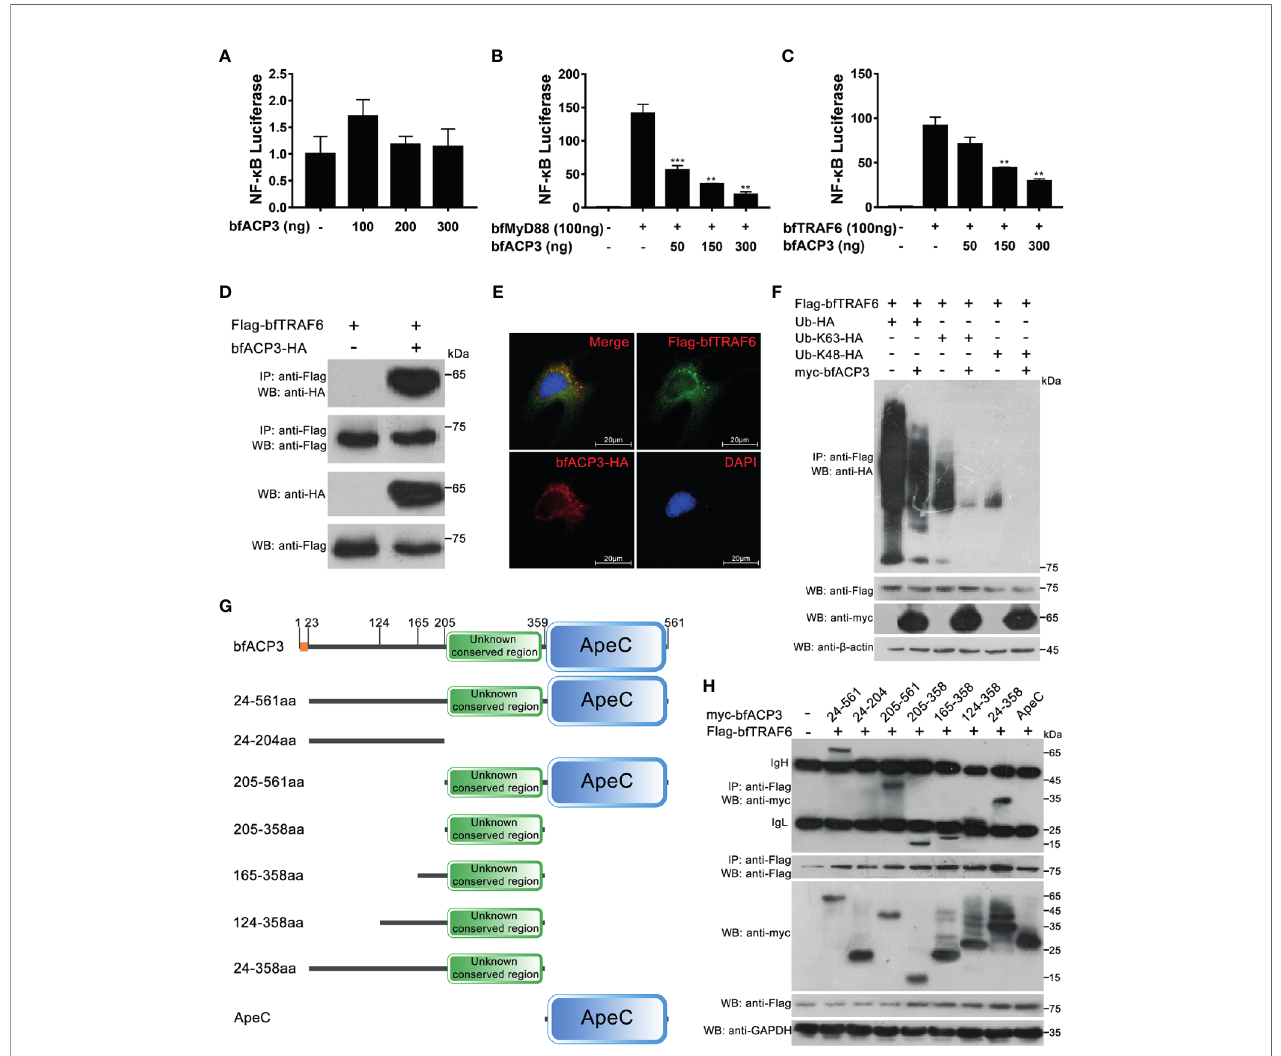
FIGURE 6 | BfACP3 negatively regulated TRAF6-NF- k B pathway by suppressing the ubiquitination of bfTRAF6. For luciferase reporter assays, HEK293T cells were co-transfected with NF- k B transcriptional luciferase reporter plasmid, Renilla luciferase reporter plasmid, bfMyD88 or bfTRAF6 vectors, together with bfACP3 vector. For Co-IP assays and colocalization assay, HEK293T cells and Hela cells were used, respectively. (A) BfACP3 hardly activated NF- k B signal. (B, C) BfACP3 negatively regulated bfMyD88-induced (B) and bfTRAF6-induced (C) NF- k B activation. The representative results are shown as means ± SD (n=3) of three experiments. ** p < 0.01, *** p < 0.001. (D) Co-IP assay showing that bfACP3 interacts with amphioxus bfTRAF6 when overexpressed in HEK293T cells. (E) Immuno fl uorescence analysis of the subcellular co-localization of bfTRAF6 and bfACP3. HeLa cells were co-transfected with HA-tagged bfACP3 and Flag-tagged bfTRAF6, then stained with rabbit anti-HA and mouse anti-Flag antibody, followed by incubating with the Alexa Fluor 568 goat anti-rabbit and Alexa Fluor 488 goat anti-mouse secondary antibody respectively. (F) Ubiquitination assays indicate that bfACP3 suppressed the polyubiquitin chains of bfTRAF6. (G) The full-length and truncated mutants of bfACP3 used in this study. The amino acids were numbered according to bfACP3 sequence. (H) Co-IP assay between bfACP3 mutants and bfTRAF6 indicated that the unknown conserved non-ApeC region of bfACP3 is responsible for the interaction with